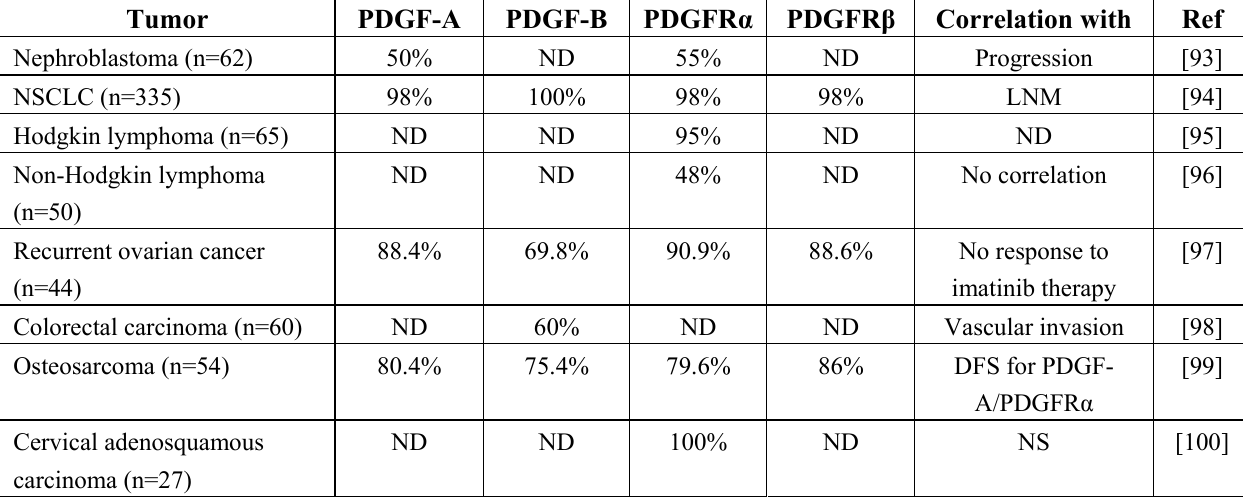
Legend: NSCLC, non-small-cell lung carcinoma; LNM, lymph node metastasis; ND,